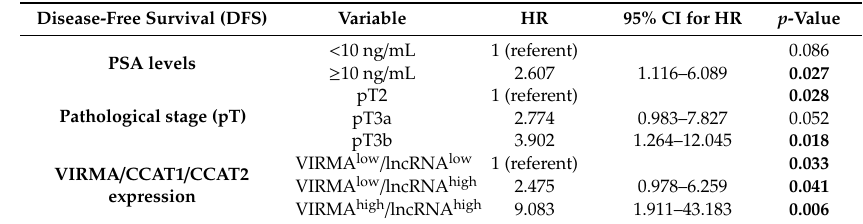
Table 1. Multivariate Cox Regression